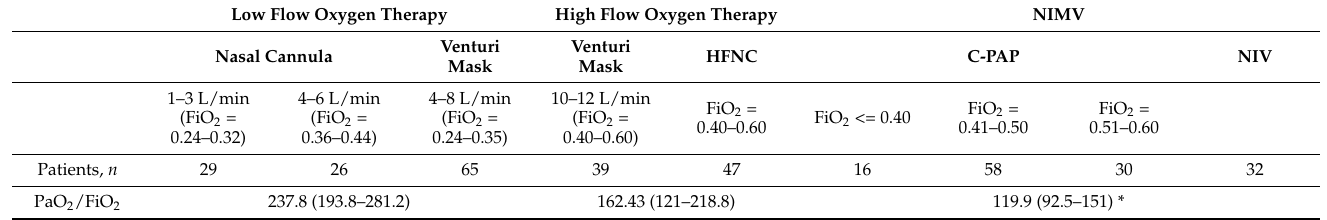
Table 1. Baseline flow rate, FiO 2 , and PaO 2 /FiO 2 of oxygen